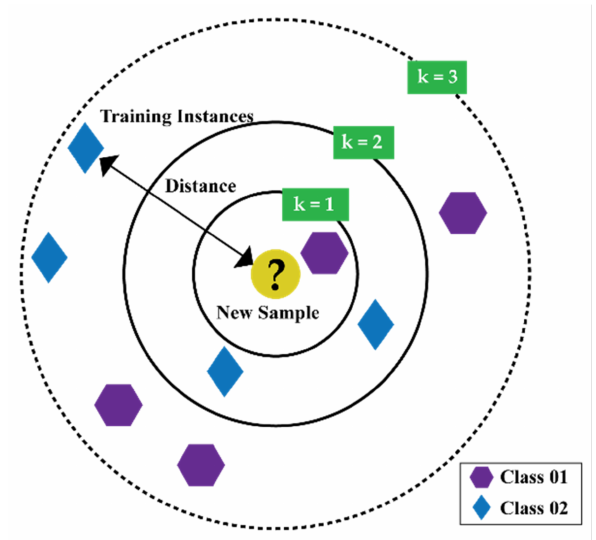
Figure 3. An illustration of the k-NN